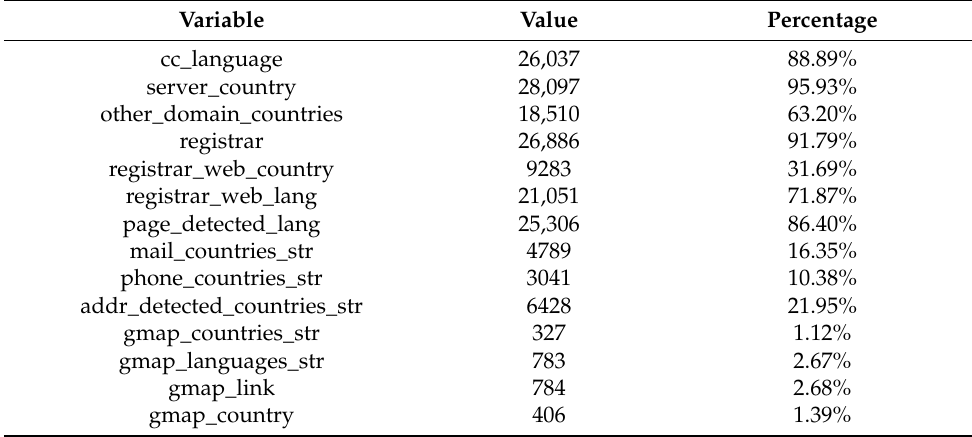
Table 5. Variables’ appearances by successfully crawled